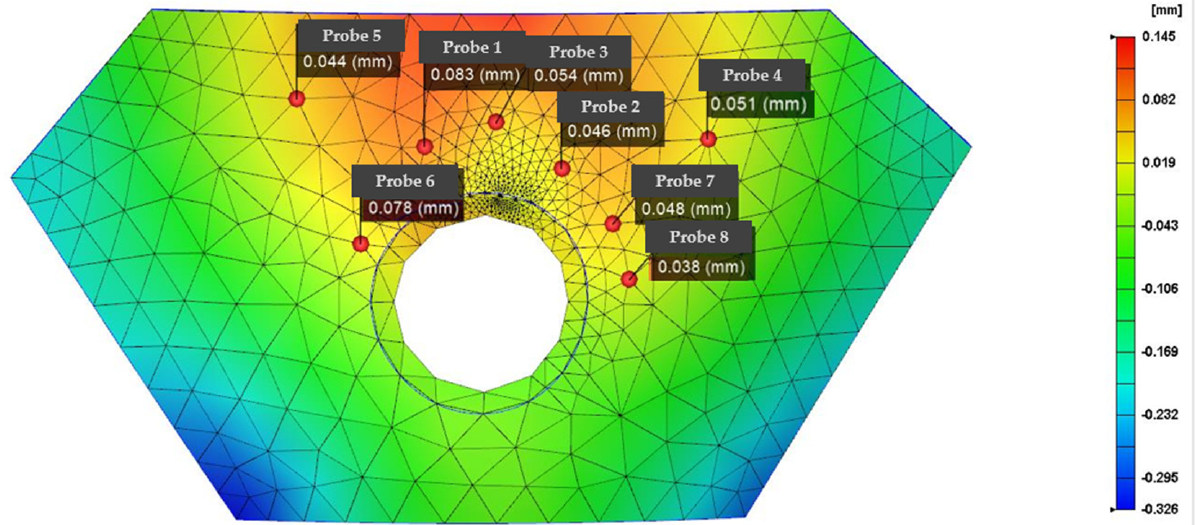
Figure 6. Optimizes the pre-armor die index analysis data graph.